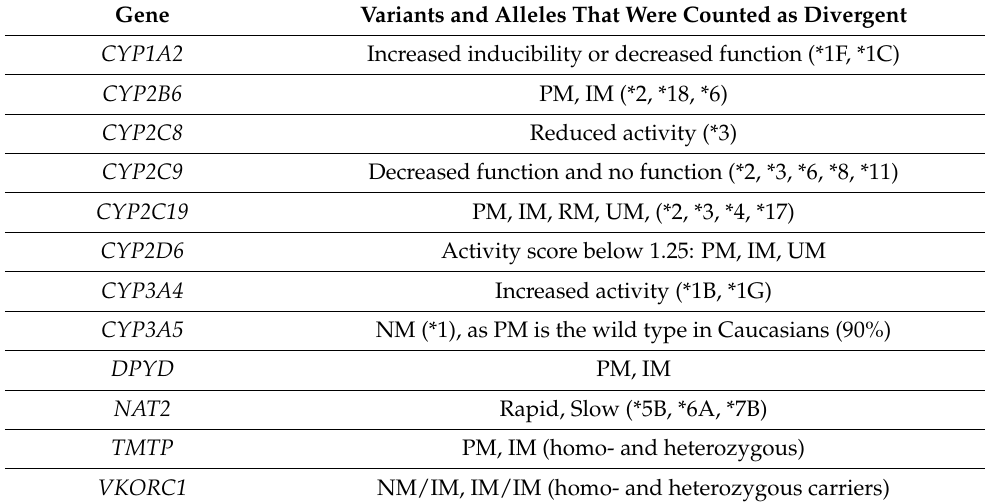
Table 1. Definition of divergent phenotypes for the analysis of important pharmacogenes. GAS = gene activity score; NM = normal metabolizer, IM = intermediate metabolizer, RM = rapid metabolizer, PM = poor metabolizer, UM = ultra-rapid metabolizer; * = allele. Gene Variants and Alleles That Were Counted as